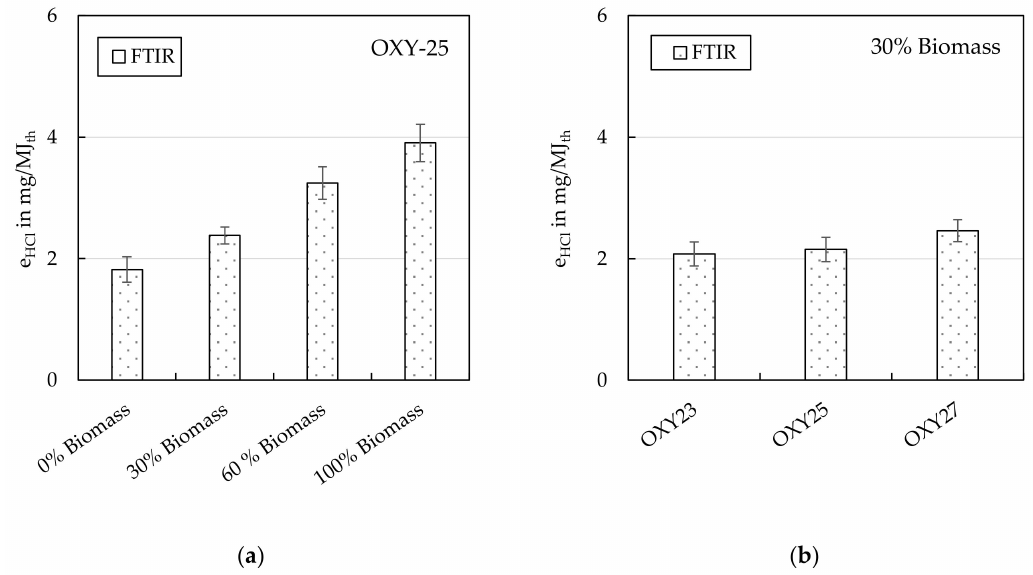
Figure 5. Specific HCl emissions ( e HCl ) as a function of the biomass share ratio ( a ) and the oxy-fuel case ( b ).